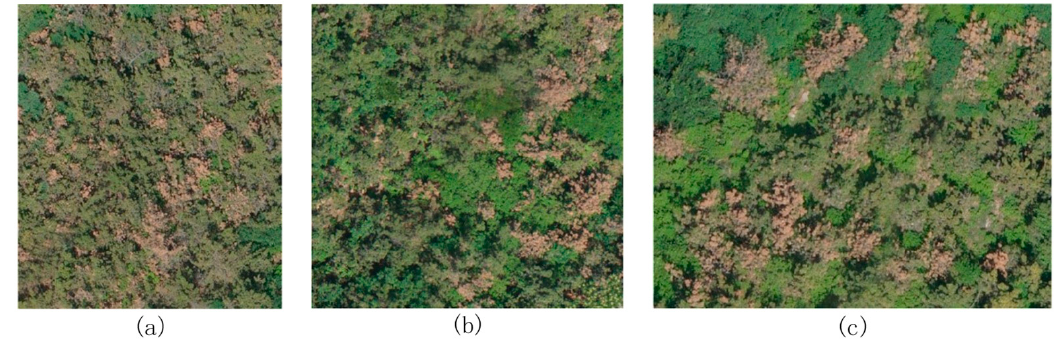
Figure 3. Test area on the UAV images. ( a ) Area 1; ( b ) Area 2; ( c ) Area 3.